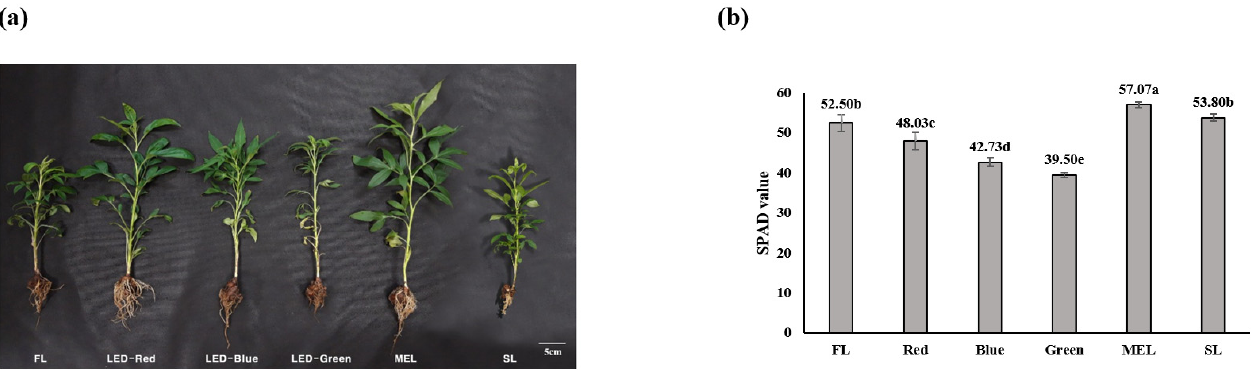
Figure 1. Growth characteristics ( a ) and chlorophyll contents ( b ) of A. macrocephala under different light sources. Values represent mean of data obtained from three independent experiments ( p < 0.05). Significance was indicated with different letters according to statistical analysis. Table 1. Growth characteristics by parts of aerial and underground in A. macrocephala treated with artificial light sources for 2 weeks.